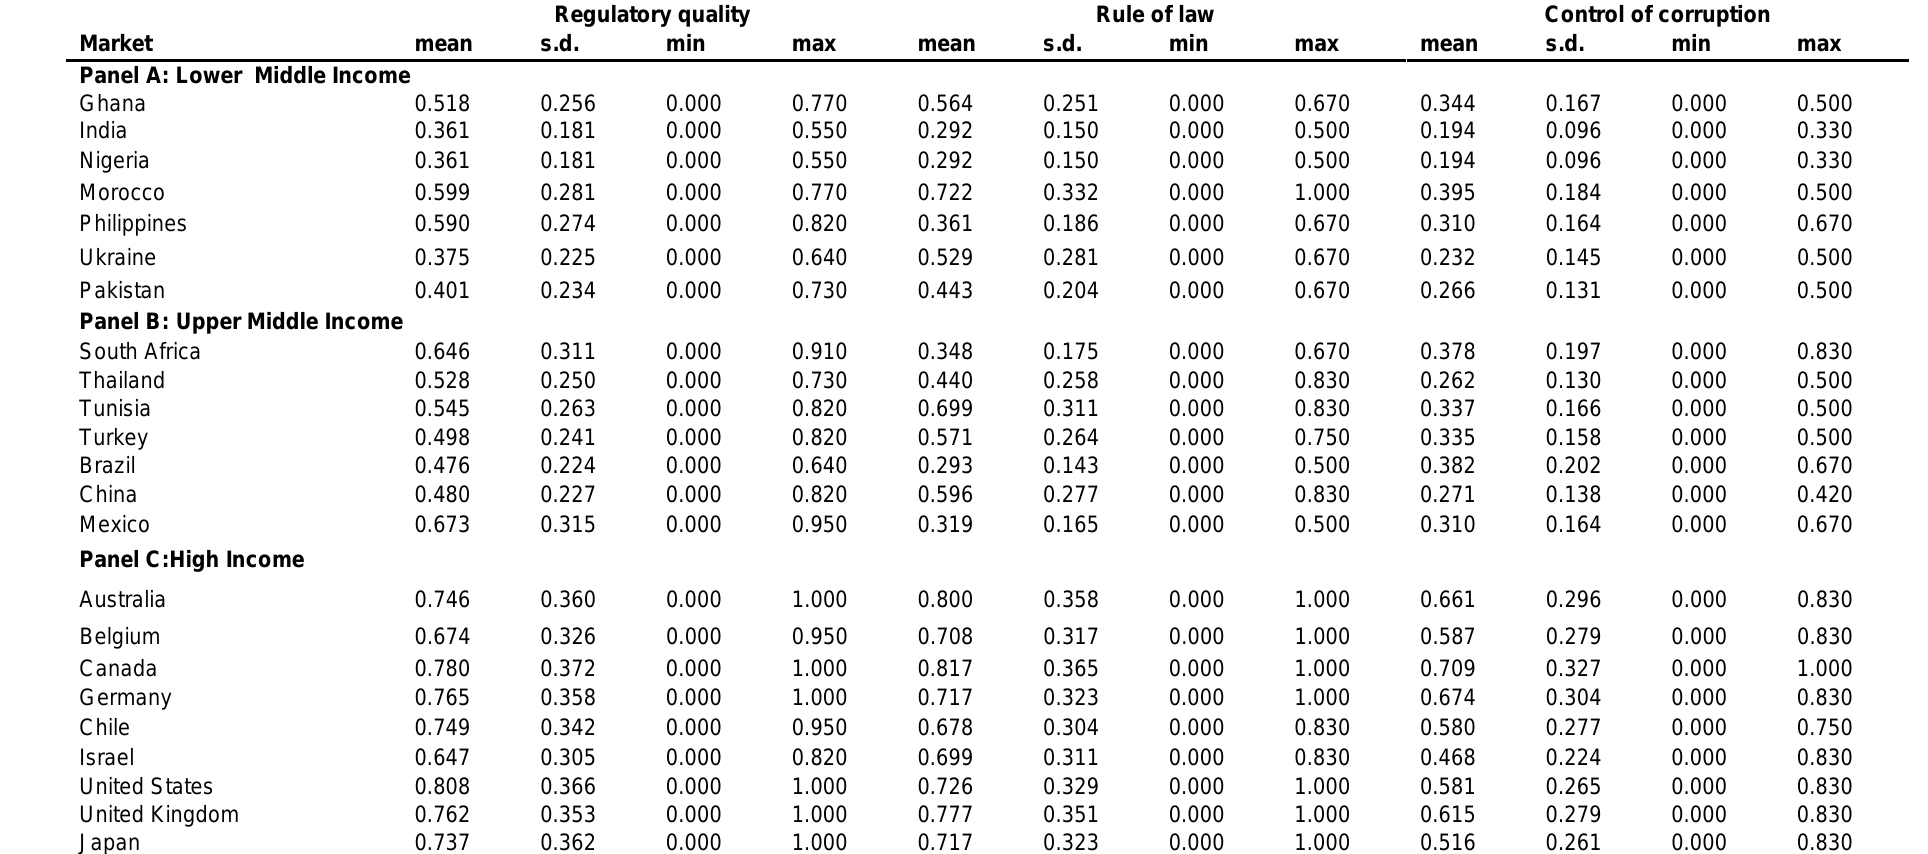
Table 6 (cont.). Summary statistics of quality governance